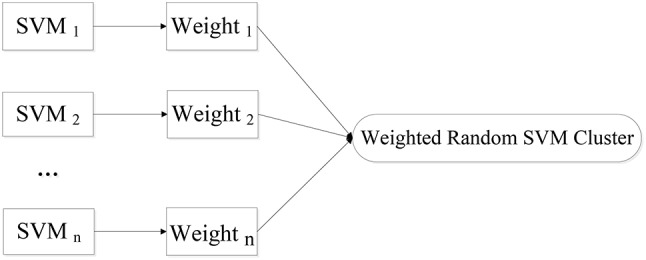
The idea of WRSVMC.